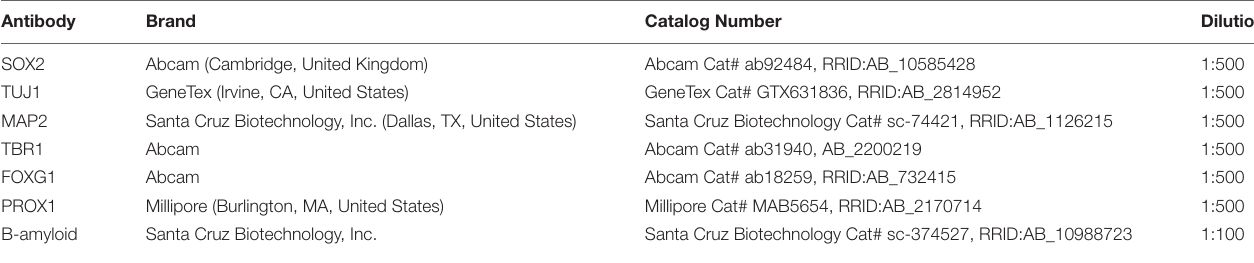
TABLE 2 | List of primary antibodies used for the immunofluorescence assay.